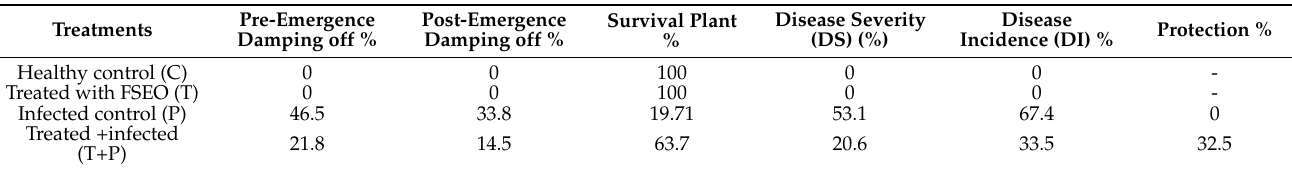
Table 3. Mean Fusarium root rot incidence and severity at pre- and post-emergence damping off after different treatments were applied to Vicia faba L.